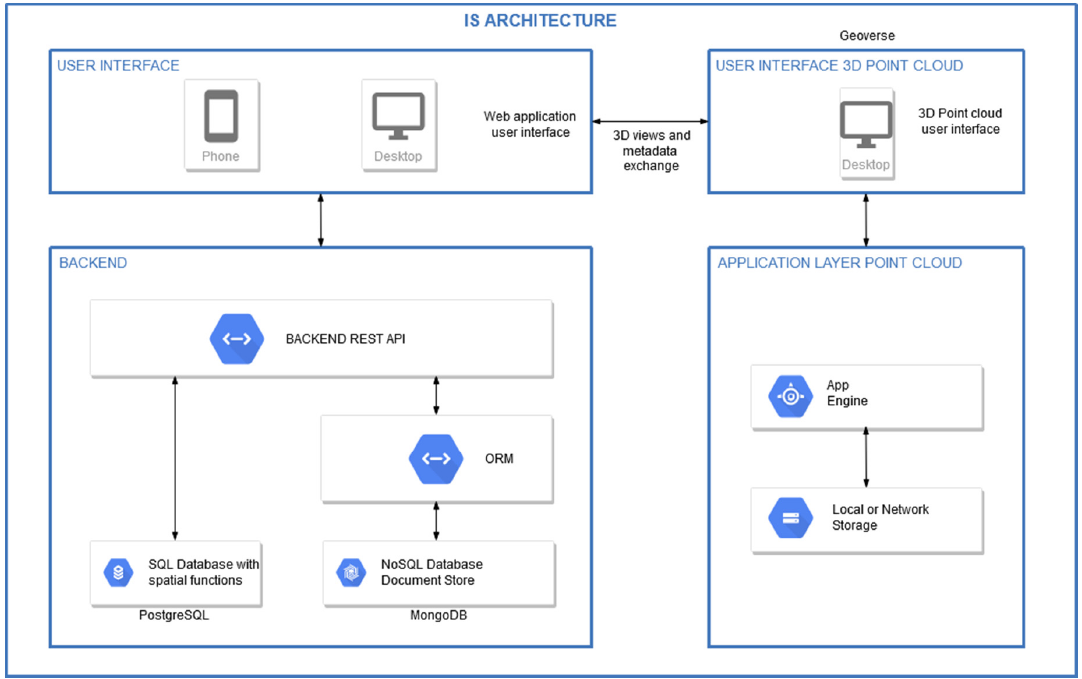
Figure 19. Implemented architecture of the Coudenberg Palace IS.